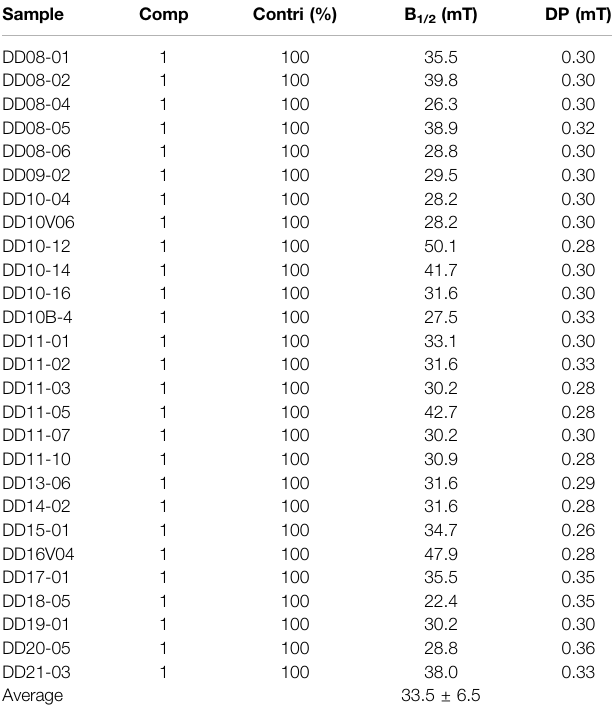
TABLE 1 | Values of midpoint B 1/2 of the IRM